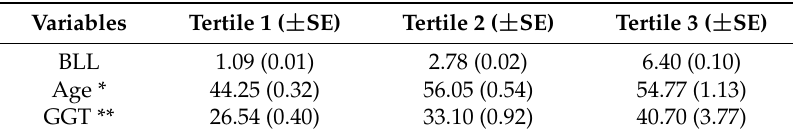
Table 7. Age and Clinical Factors and Tertiles of Exposure.